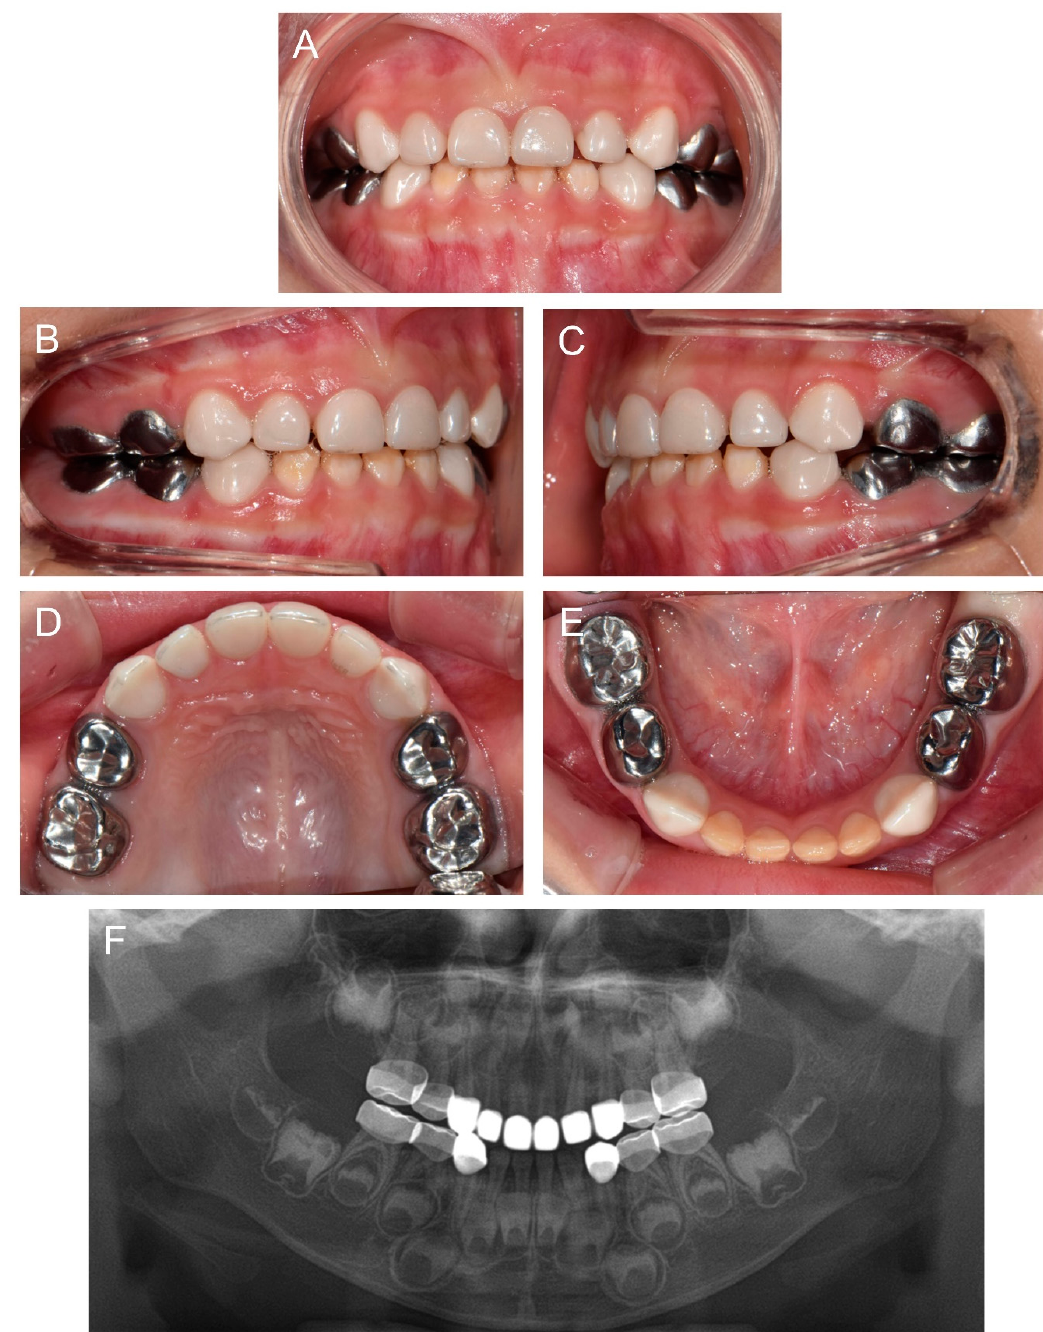
Figure 3. Clinical photos and panoramic radiograph of the proband at age 3 years 11 months. ( A – E